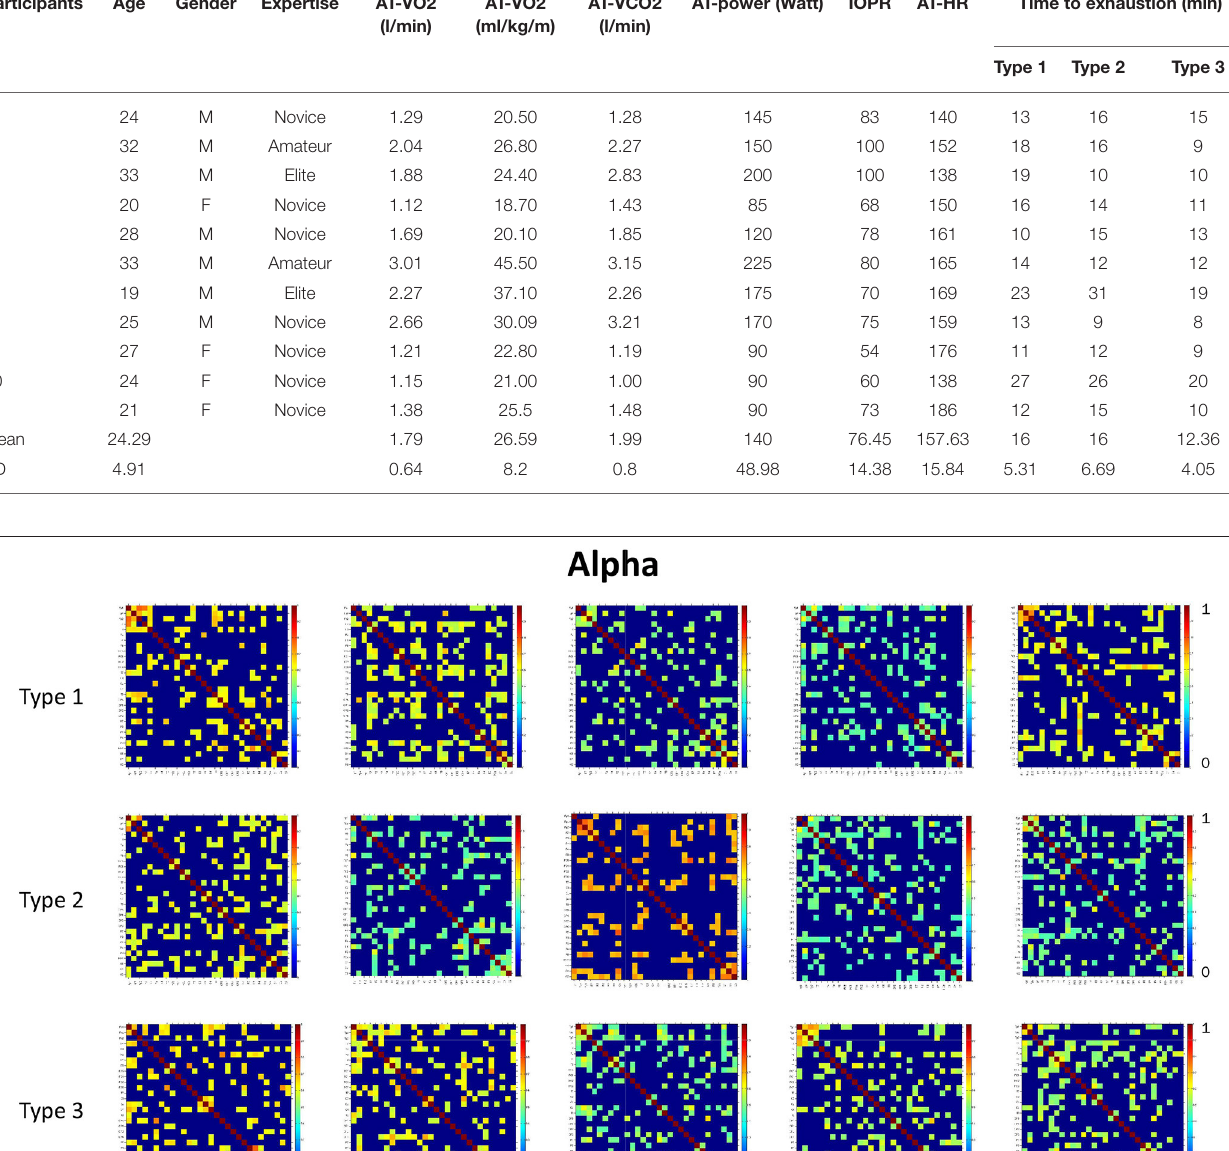
Frontiers in Psychology |